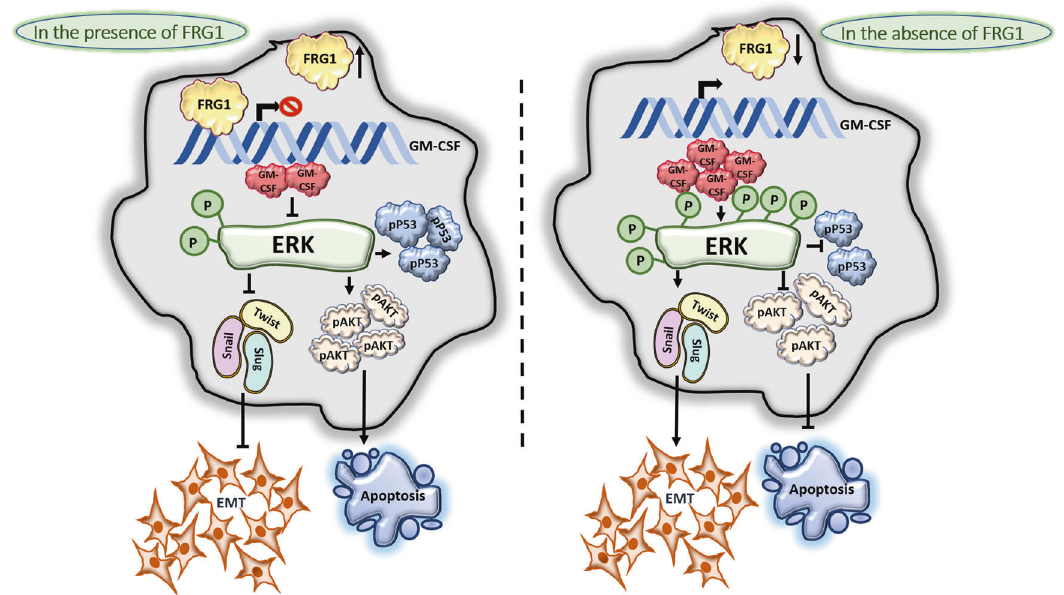
Fig. 8 Schematic showing direct transcriptional regulation of FRG1 in suppressing GM-CSF mediated breast carcinogenesis. Left side of the illustration describes FRG1-mediated transcriptional repression of GM-CSF. FRG1 binds to the GM-CSF promoter and suppresses its transcription. In the presence of an optimal amount of FRG1 and lesser GM-CSF, activation of ERK gets reduced, which in turn downregulates snail, slug, and twist mediated EMT. On the other hand, a depleted level of pERK promotes the activation of AKT and p53 that facilitates apoptosis of the cells. Thus, the presence of FRG1 protects cells from GM-CSF-mediated tumorigenesis. Right panel shows the opposite effect that occurs due to a depleted level of FRG1. FRG1 downregulation leads to the upregulation of pERK. An increased amount of activated ERK inhibits the expression of pAKT and pP53 simultaneously, which in turn, inhibits cell apoptosis. Also, the upregulation of pERK increases the expression of EMT markers that leads cells toward EMT. Thus our model demonstrates FRG1-mediated suppression of breast carcinoma via GM-CSF/MEK/ERK